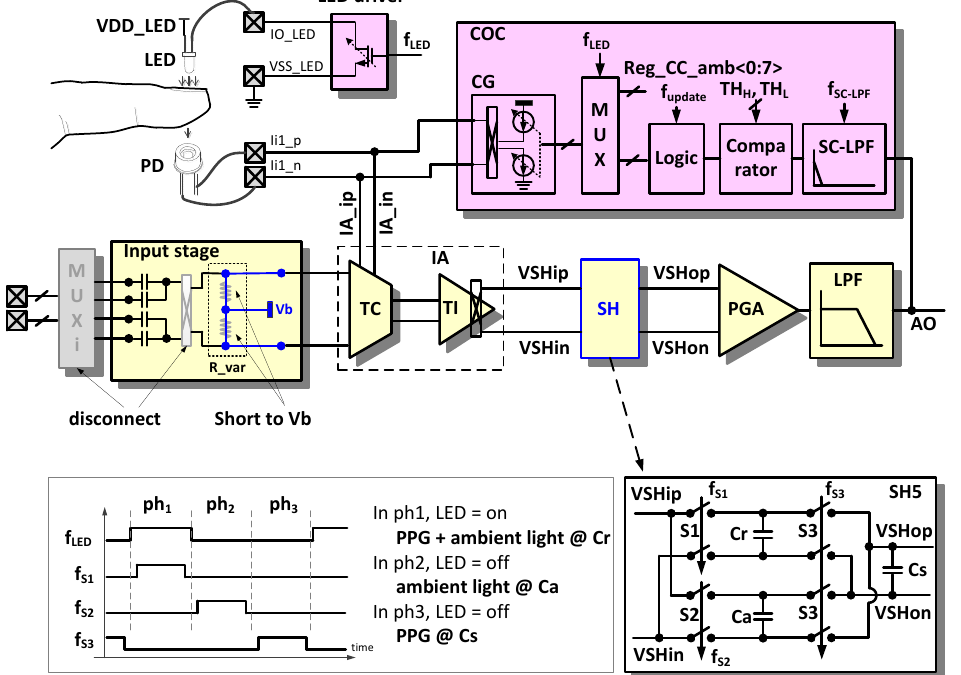
Figure 7. Reconfiguration of the readout channel for photoelectric (PE) sensing mode.